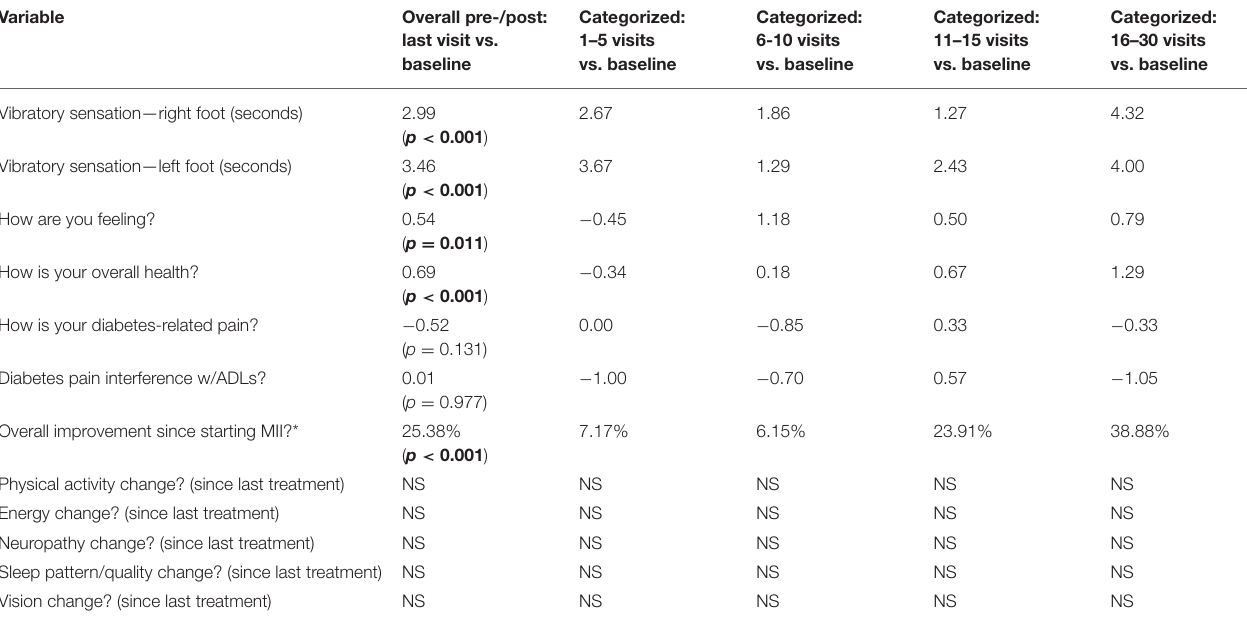
TABLE 4 | T -tests: significance of pre-/post-differences in outcome measures—patient-reported/subjective data. Variable Overall pre-/post: last visit